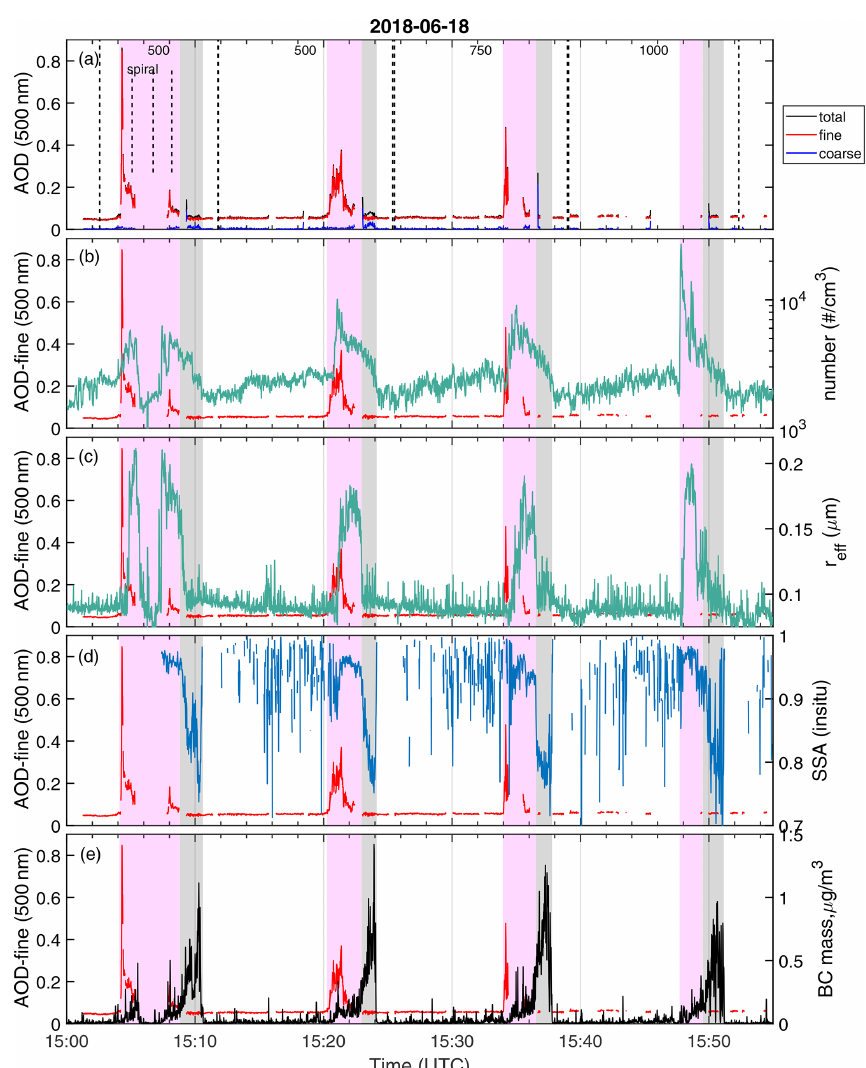
Figure 7. Panels (a) – (c) as in Fig. 3. (d) SSA440 from nephelometer and CLAP, unitless; (e) black carbon mass, µgm − 3 . The pink and grey rectangles represent plumes A and B respectively as discussed in the text. UTC